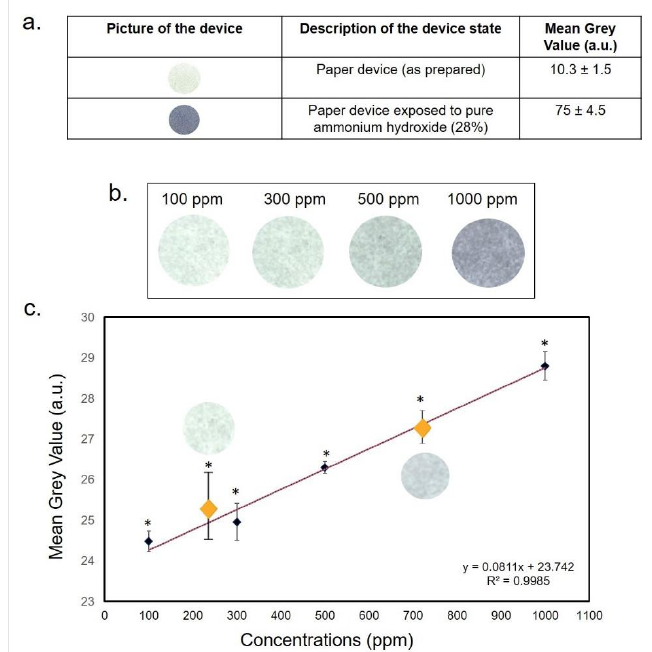
Figure 5. ( a ) Mean Gray Value (MGV) values of PAD as prepared and after the exposure to pure NH 3 (28%). ( b ) color change after NH 3 exposure. ( c ) Interpolation of NH 3 intermediate values (200 and 750 ppm). Data reported were the average of three independent experiments ± SD. The di ff erence